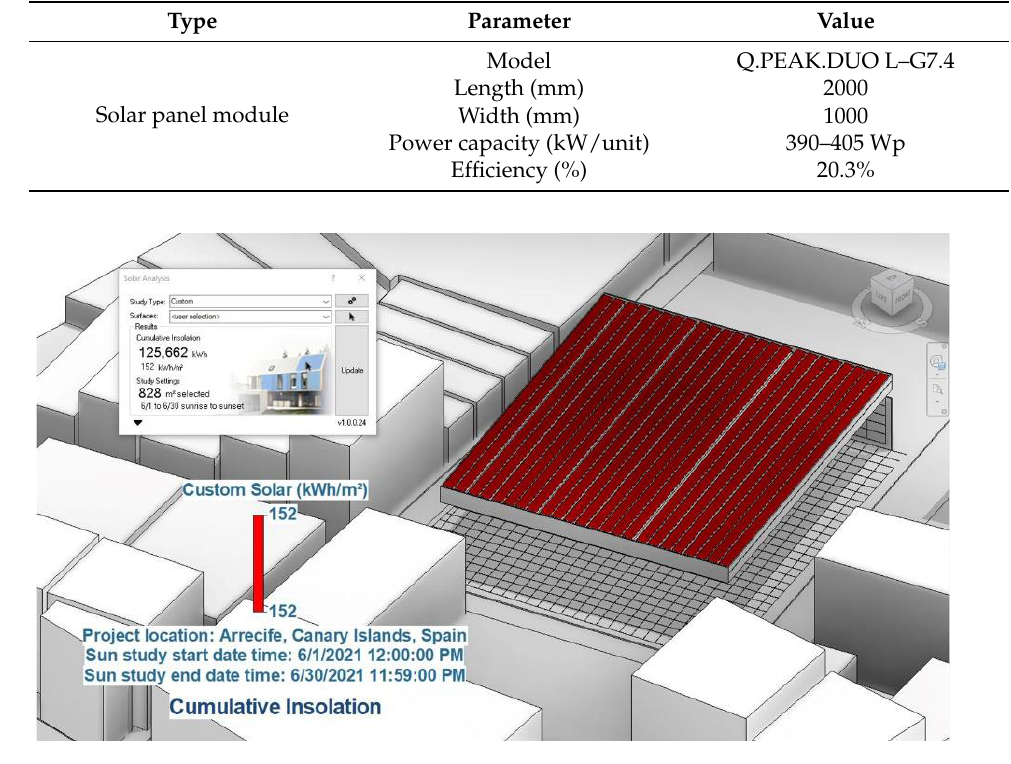
Table 3. Monthly solar energy generations by solar panels using the optimal tilt angle ( βо ). N.